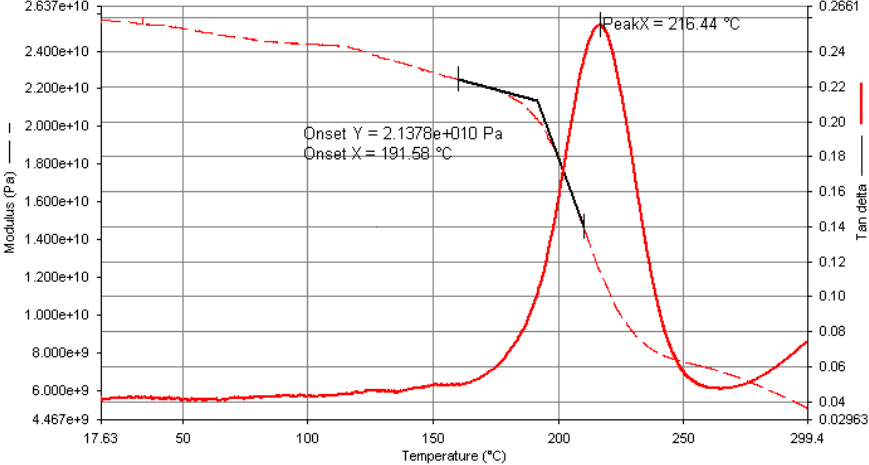
Figure A2 . Storage modulus and tangent delta curves collected during DMA analysis of CFRE panel.